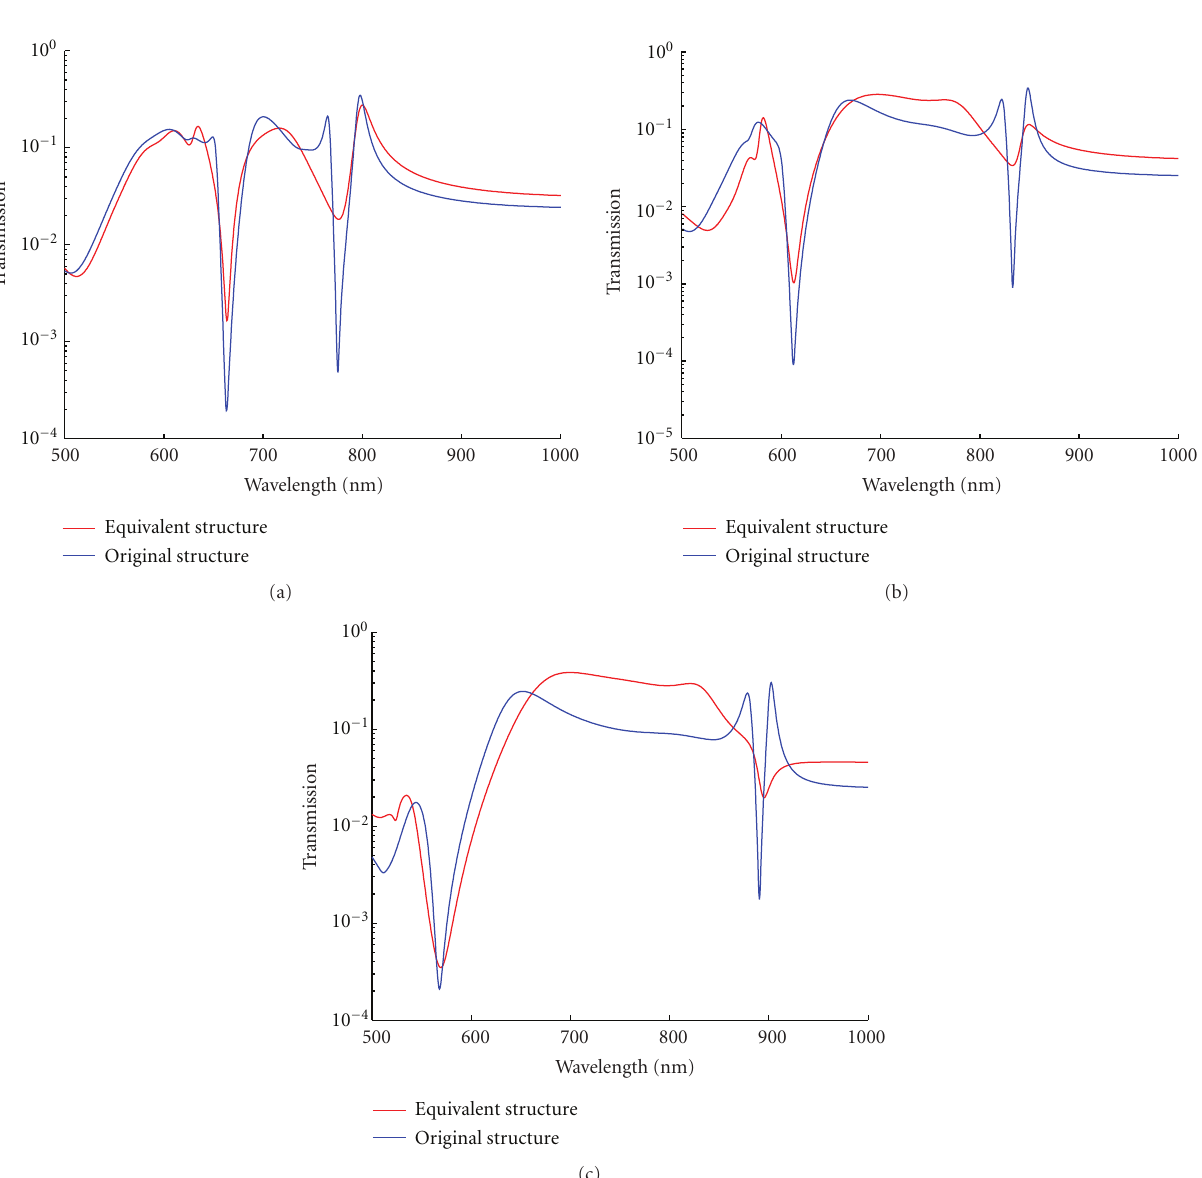
Figure 8: Blue lines report the transmission diagrams already presented in Figure 5 in logarithmic scale, whereas red lines display on the same scale the results obtained by the equivalent structures with the parameters listed in Table 1. The angles of incidence of the input light for the original arrays are (a) θ = 5 ◦ , (b) θ = 10 ◦ , and (c) θ = 15 ◦ .